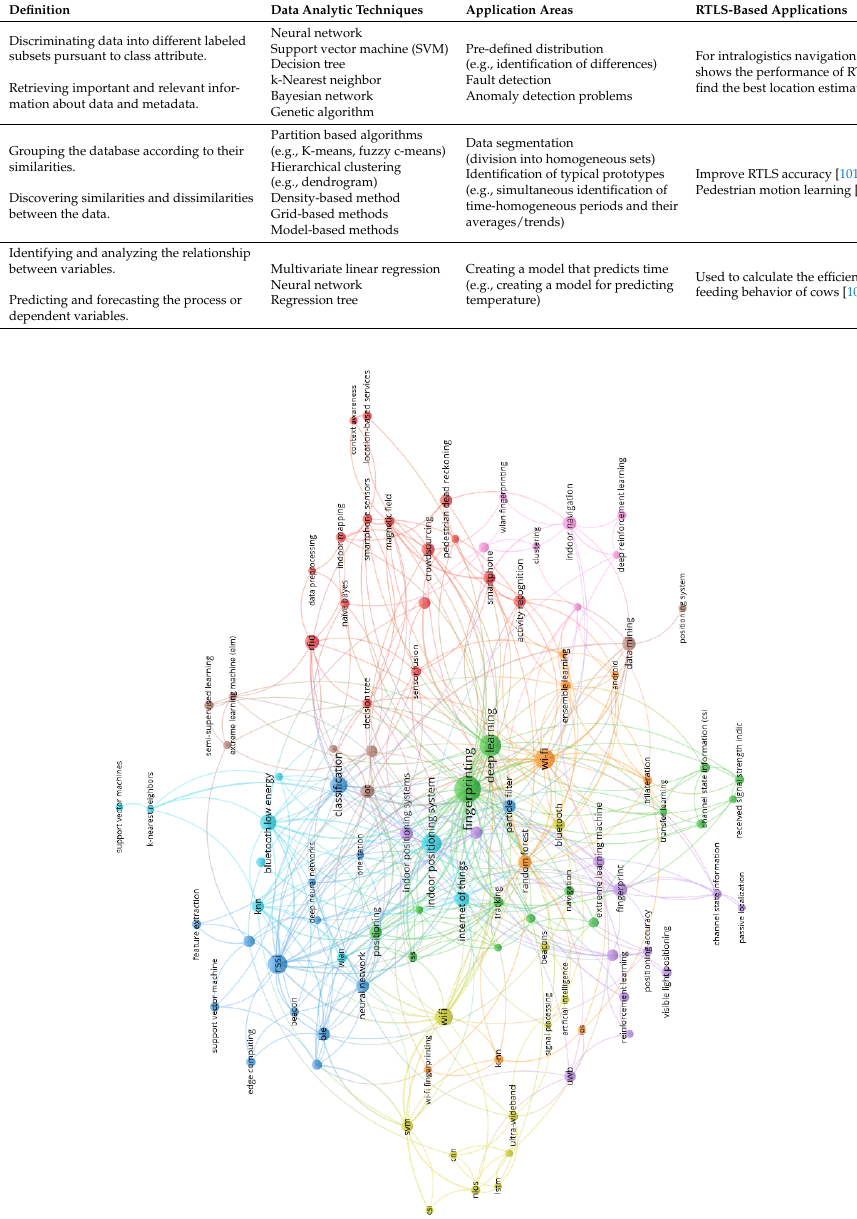
Figure 4. Network of keywords based on Scopus